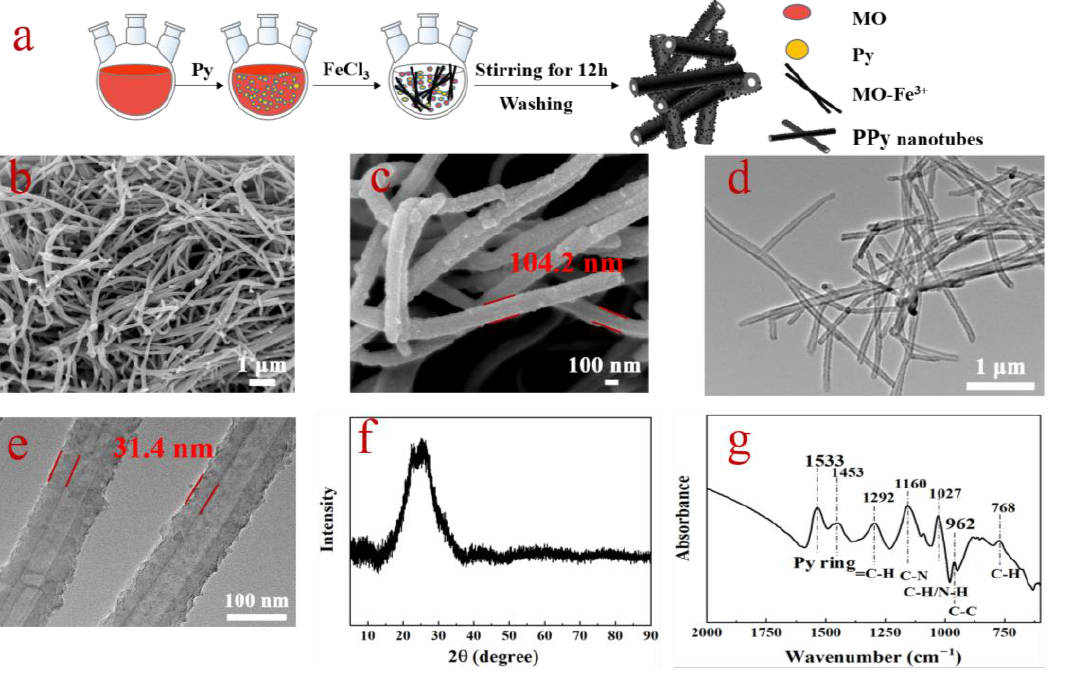
Figure 1. ( a ) The schematic illustration of synthesis of PPyNT; ( b , c ) SEM images, ( d , e ) TEM images, ( f ) XRD pattern and ( g ) IR spectrum of typical PPyNT.